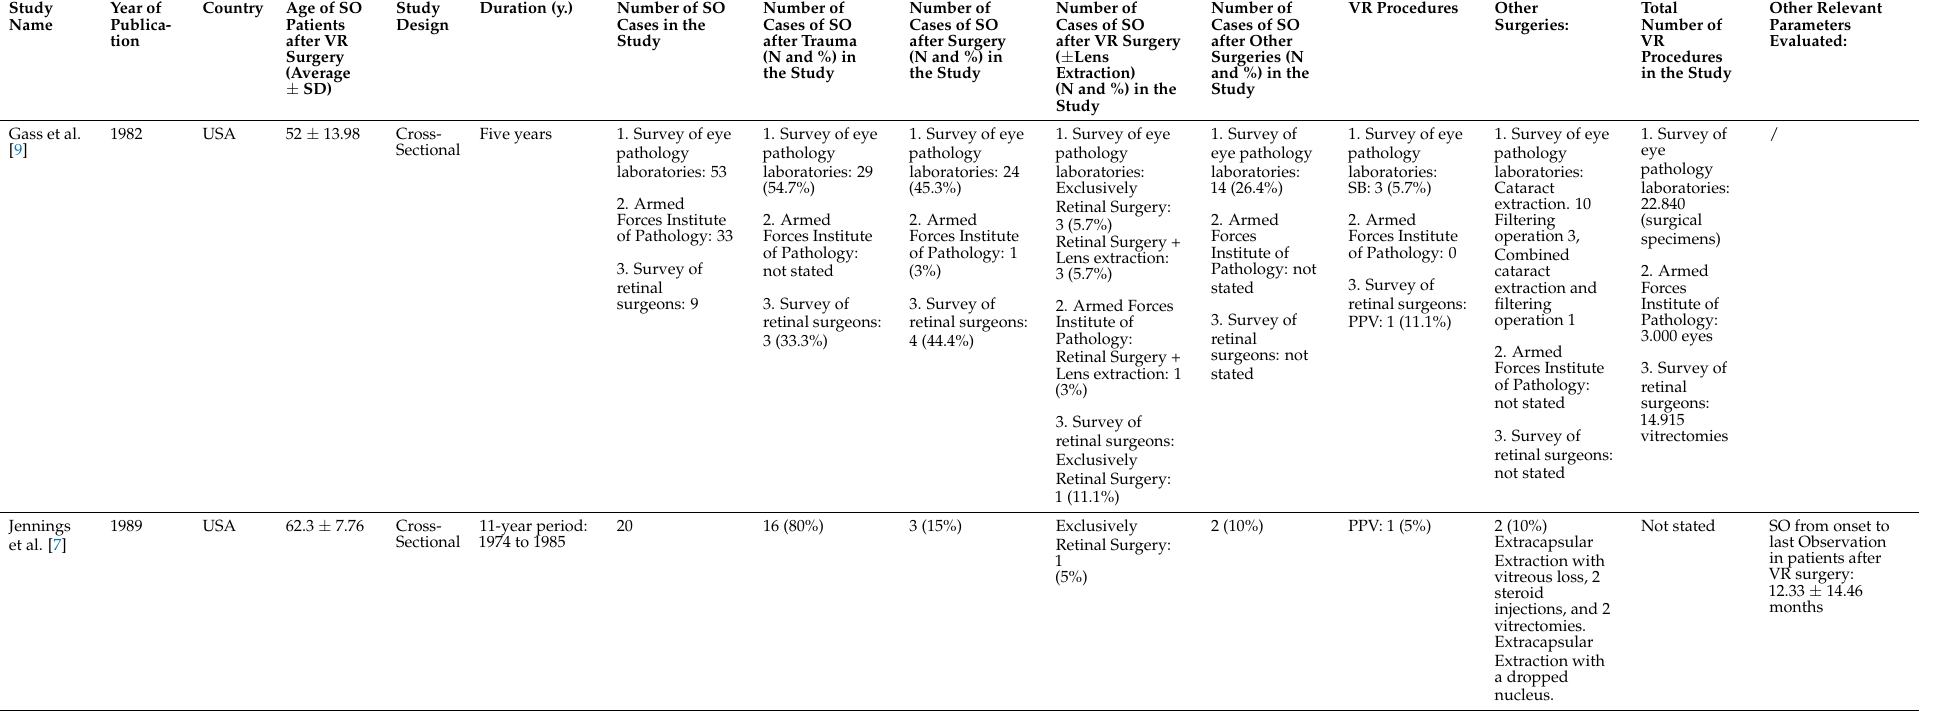
Table 1. Characteristics of studies included in the systematic